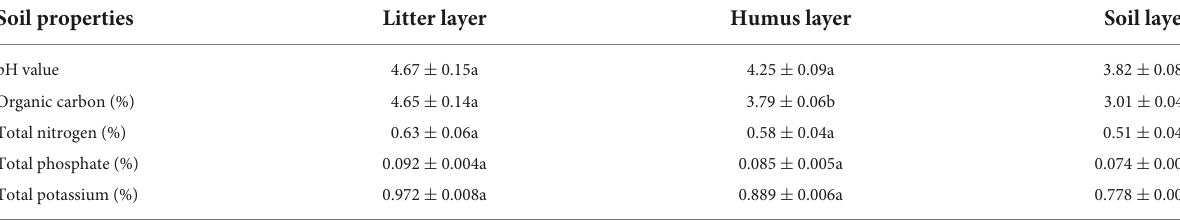
TABLE 1 Soil properties of the three sampled layers collected from Rhododendron delavayi forest.